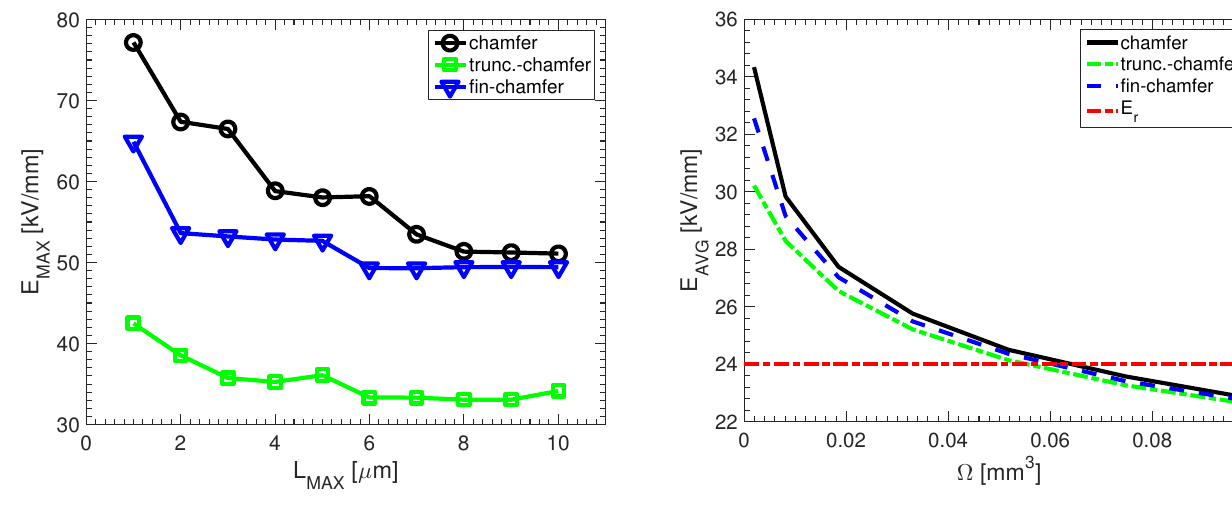
Figure 10: E MAX vs. L MAX for the three singularity shapes under investigation. The sharpness of the singularity end- tip and the mesh refinement strongly influence E MAX . Fur- thermore, even the E MAX ratio among singularities de- pends on L MAX .